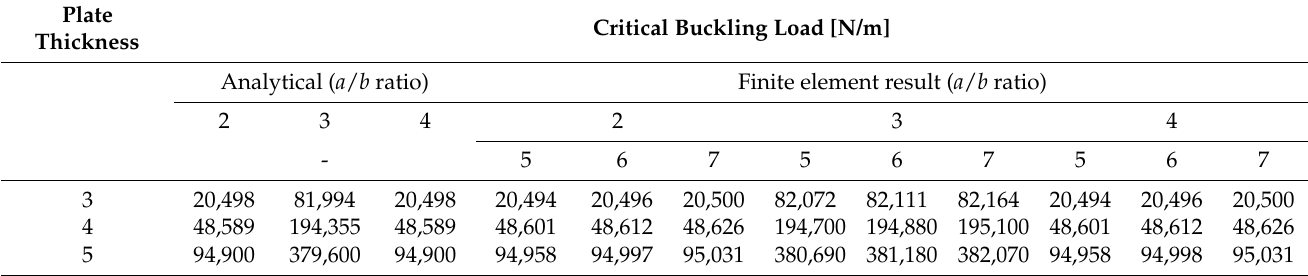
Table 7. Critical buckling load of the rectangular plate depend on the plate thickness h